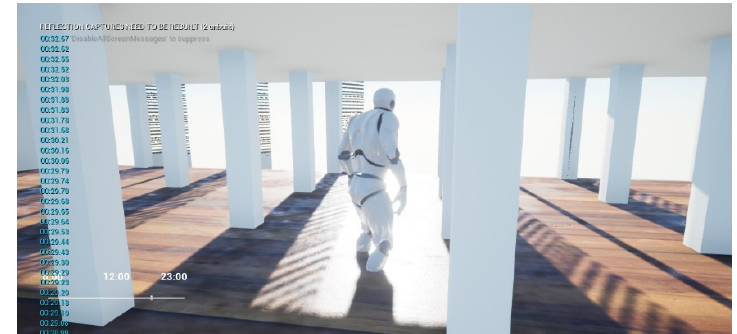
Figure 18. Immersive View of the Interactive Facade with Light and Textures.